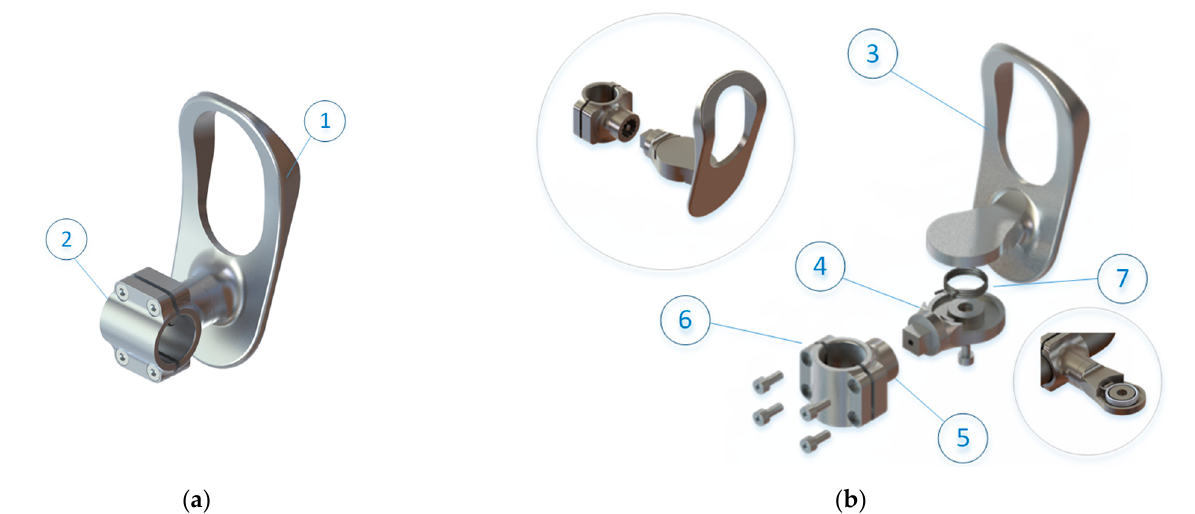
Designs 2021 , 5 , x FOR PEER REVIEW Figure 9. Three-dimensional model visualization: ( a ) short-fixed system with a leaf (1) and a clamped system (2); ( b ) dynamic system with a leaf (3), a flat hinge component (4), a handle clamp system with two components (5,6) and a torsional spring (7).